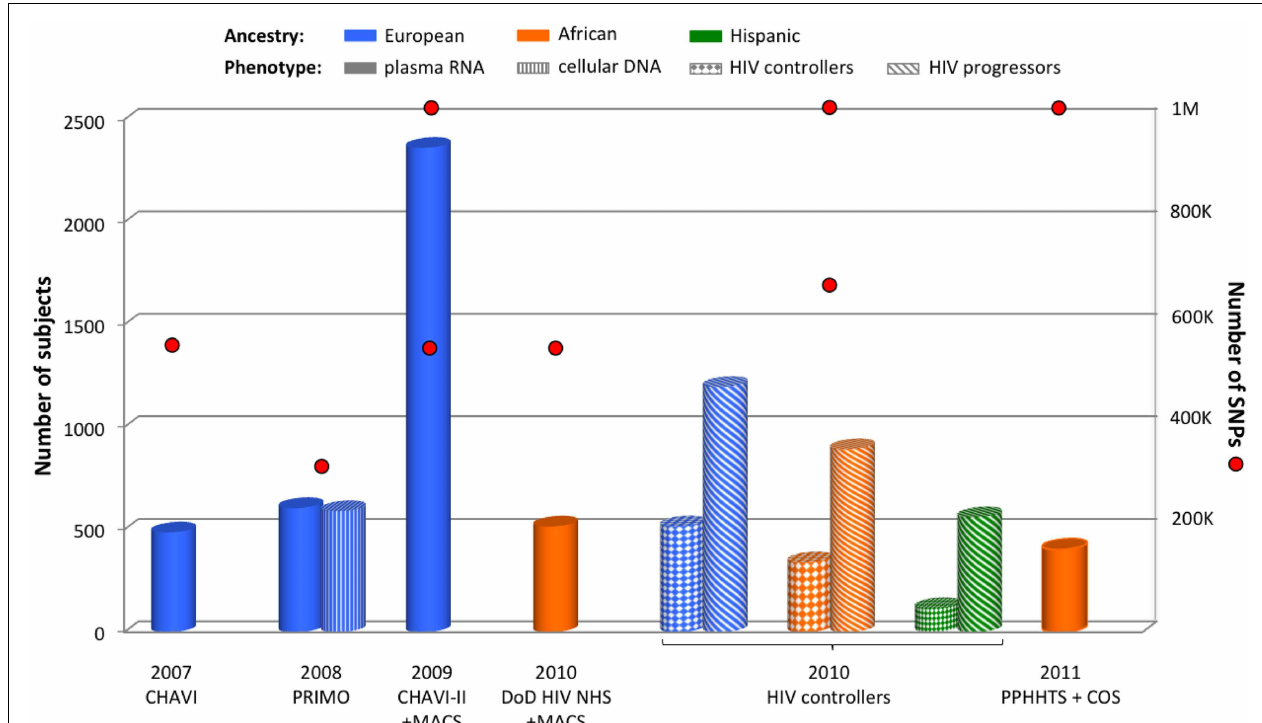
Individual ancestry is color-coded: blue for European, orange for African, and green for Hispanic.The pattern of each cylinder illustrates the phenotype of interest: plain color for plasma RNA, vertical stripes for cellular DNA, solid diamonds for HIV controllers, and diagonal stripes for HIV progressors.